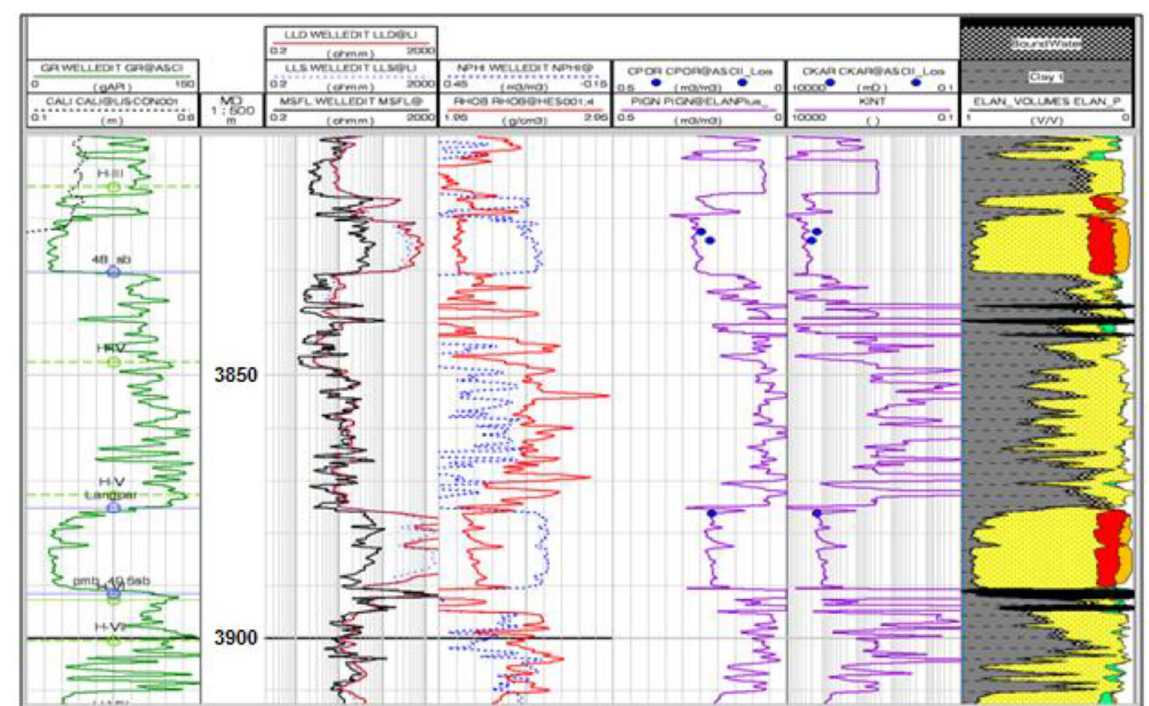
Fig. 5 Crossplot between porosities derived from density and ELAN interpretation in